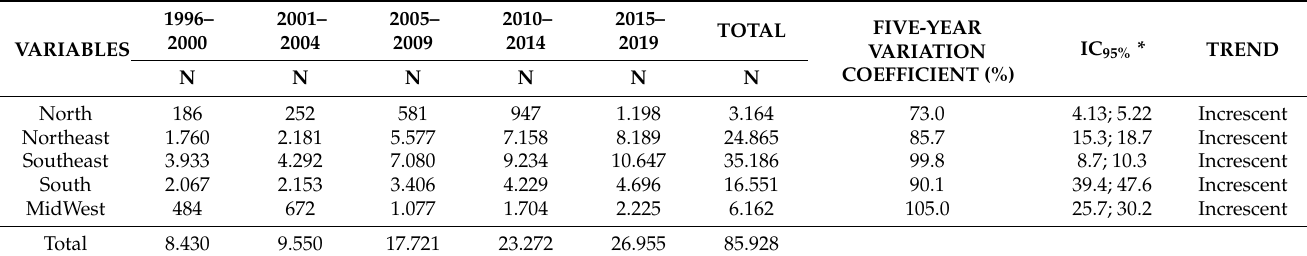
Table 4. Number of deaths, evolution of the coefficient and trend of deaths of elderly people from alcohol consumption in macro-regions, Brazil,